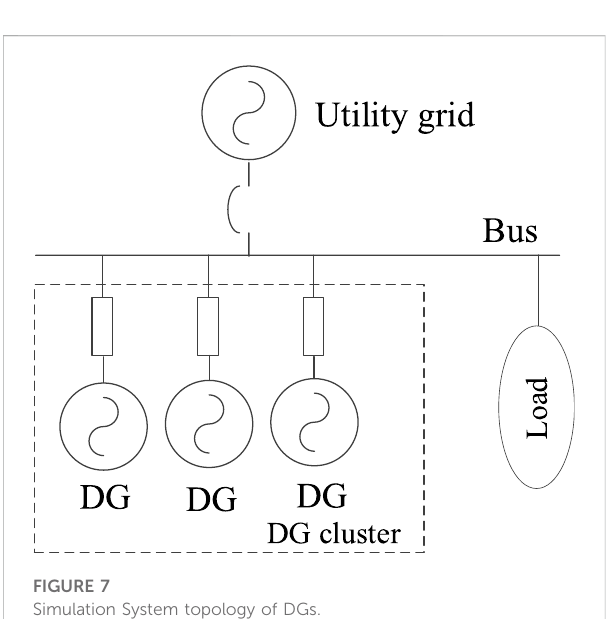
FIGURE 7 Simulation System topology of